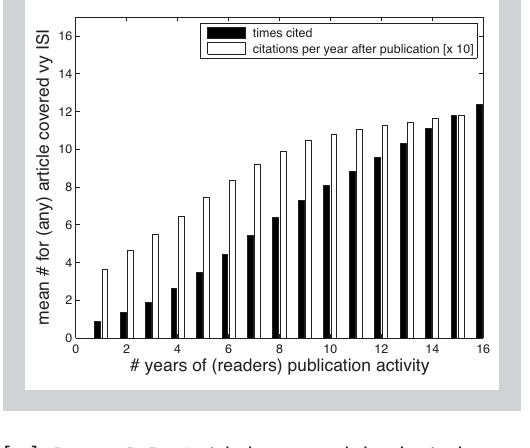
algorithm for predicting the linear viscoelastic